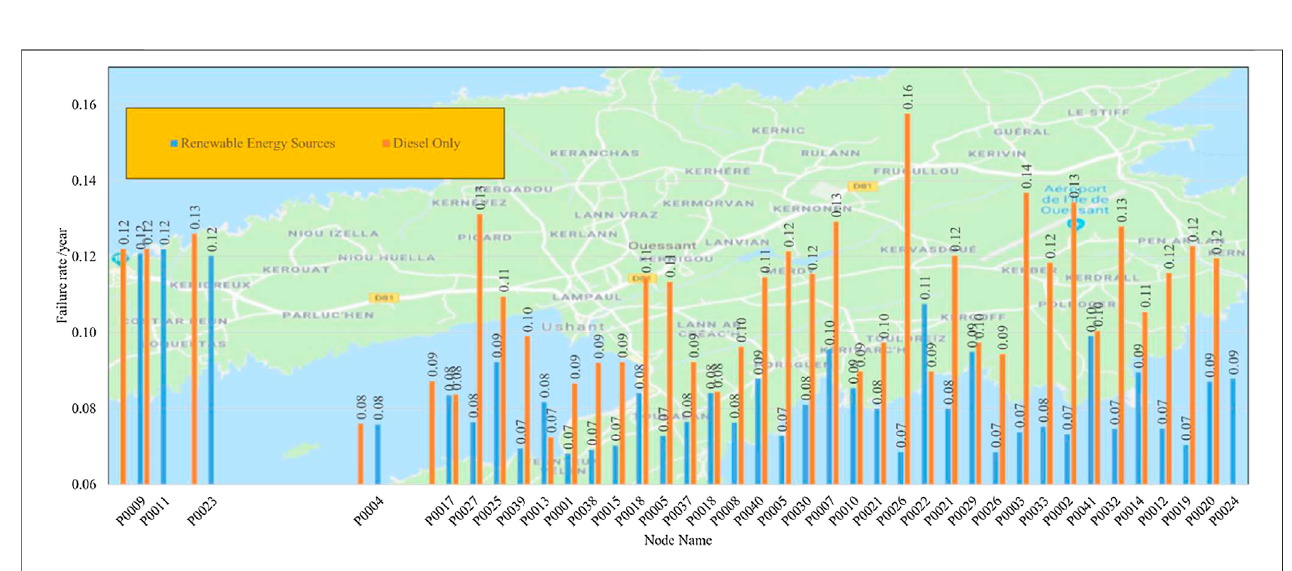
FIGURE 20 | Load node failure rate under diesel and renewable energy